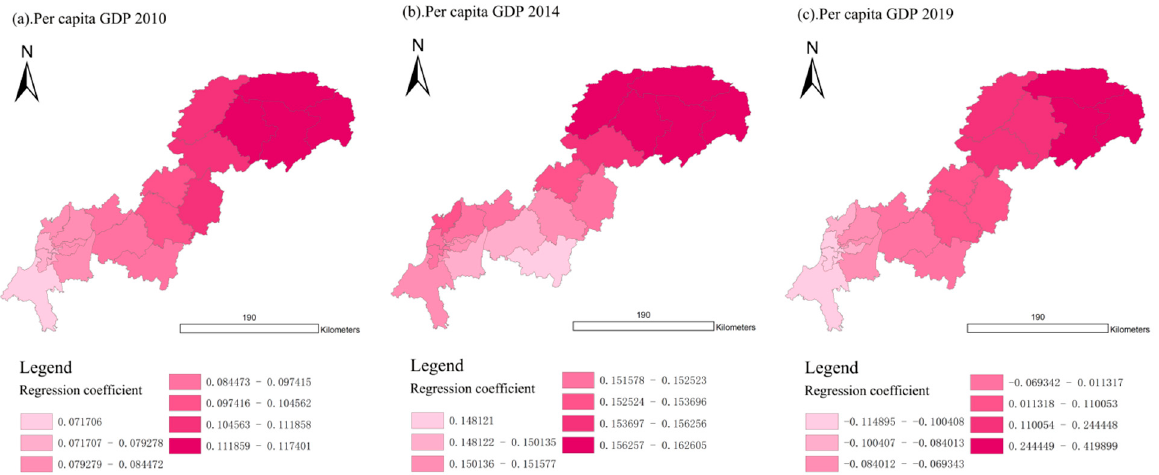
Figure 14. Spatial distribution of regression coefficient of E-UDI in year 2010, 2014, and 2019 (presented in subfigure a – c , respectively). Sources: Calculation results of the GWR model from the economic dimension.